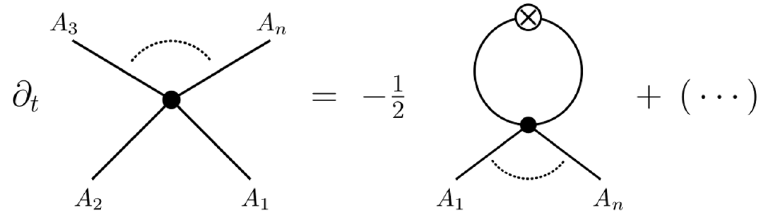
Figure 7 . Simpli(cid:12)ed diagrammatic representation of the (cid:13)ow equation for the n -point vertex (cid:0) ( n ) ( p ). Here we have used ( (cid:1) (cid:1) (cid:1) ) to denote that there are other diagrams contributing to k;A 1 (cid:1)(cid:1)(cid:1) A n the (cid:13)ow